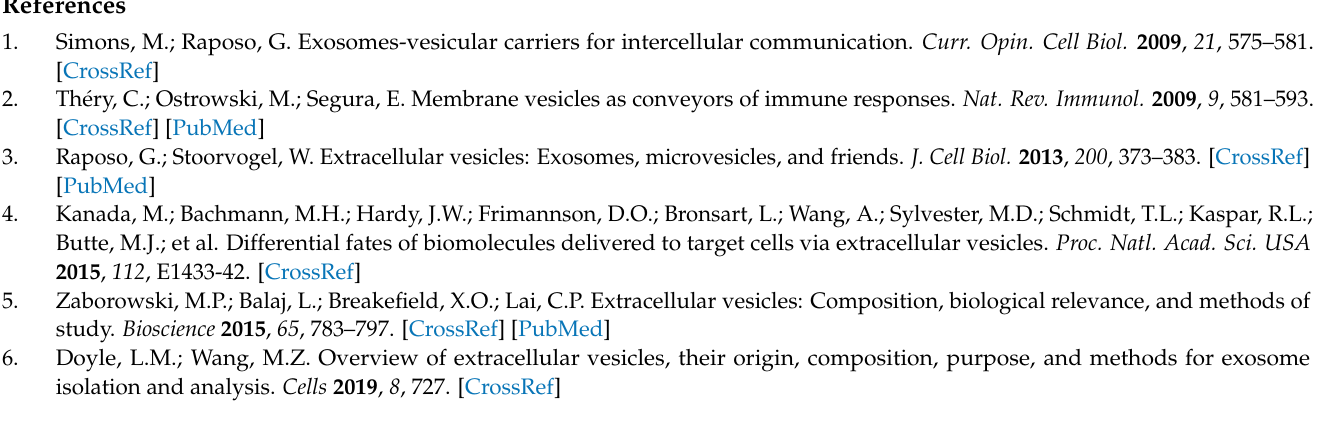
Figure S3: Profiles of EV-derived RNA from five different cell lines. Figure S4: Detection of GAPDH mRNA in EVs by glyoxal Northern blot analysis. Table S1: DNA-oligonucleotides and